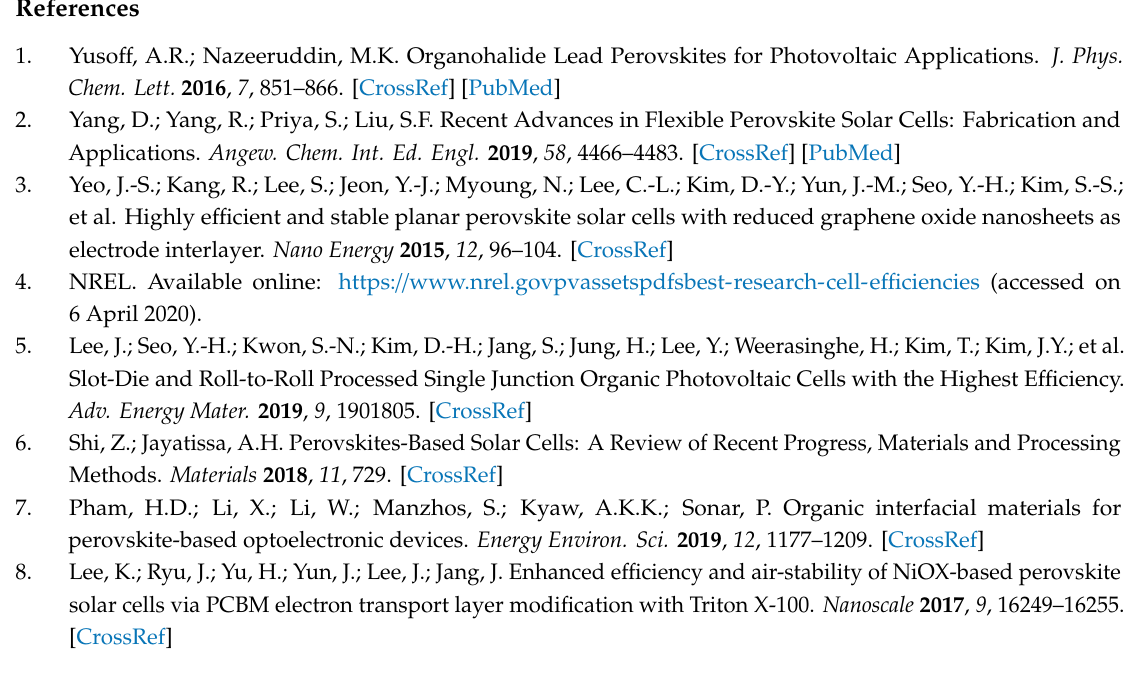
Figure S1: Current density–voltage (J–V) curves of the PSC according to the concentration change of ( a ) ITIC, ( b ) IT-4f, and ( c ) COi8DFIC. Figure S2: ( a ) Top-view SEM and ( b ) AFM images (scale: 5 × 5 µ m) of PCBM films coated on the ITO / NiOx / perovskite layer. ( c ) Schematic energy level diagram of the perovskite and PCBM ETLs. ( d ) C-AFM image (scale: 2 × 2 µ m) of the PCBM film. Table S1: Fitting parameters of bi-exponential decay function in transient photovoltage measurement. Table S2: Fitting parameters of bi-exponential decay function in transient photocurrent